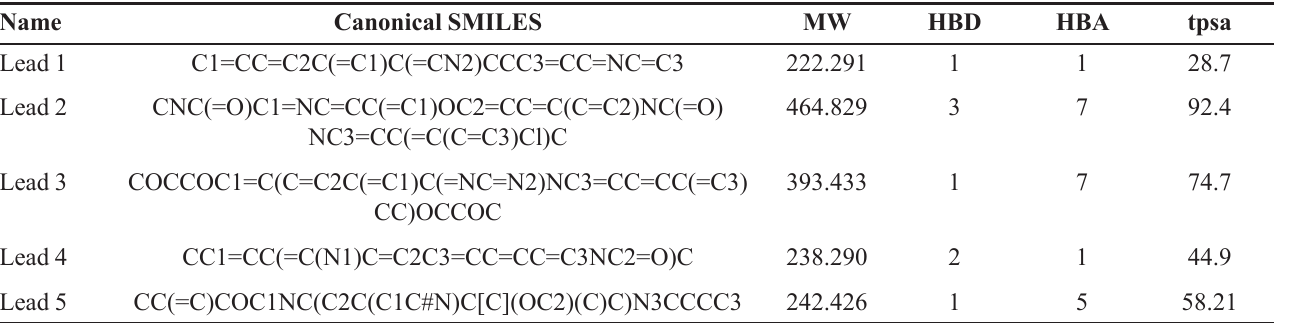
TABLE I - Details of the top five compounds